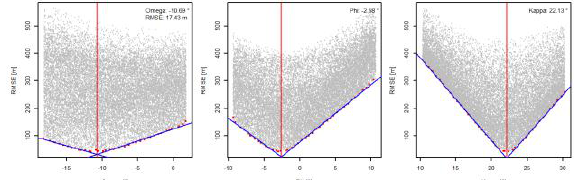
Figure 3 : Rotation angle estimates with forward Monte-Carlo estimate. 20 thousand runs were computed in two passes. The first crudely determines the approximation value of omega, phi, kappa. A second pass of 20 thousand runs refines the domain where the optimal value lies. The optimal angle is then determined by robust least square fit of minimal RMSE on either side. These graphs for omega, phi, kappa, respectively cover the same angular span. Omega is the least well determined parameter as regression lines are flatter. On the other hand, for kappa, the solution is tighter. This comes from the acquisition geometry of the flight path. The overall RMS error where regression lines meet is